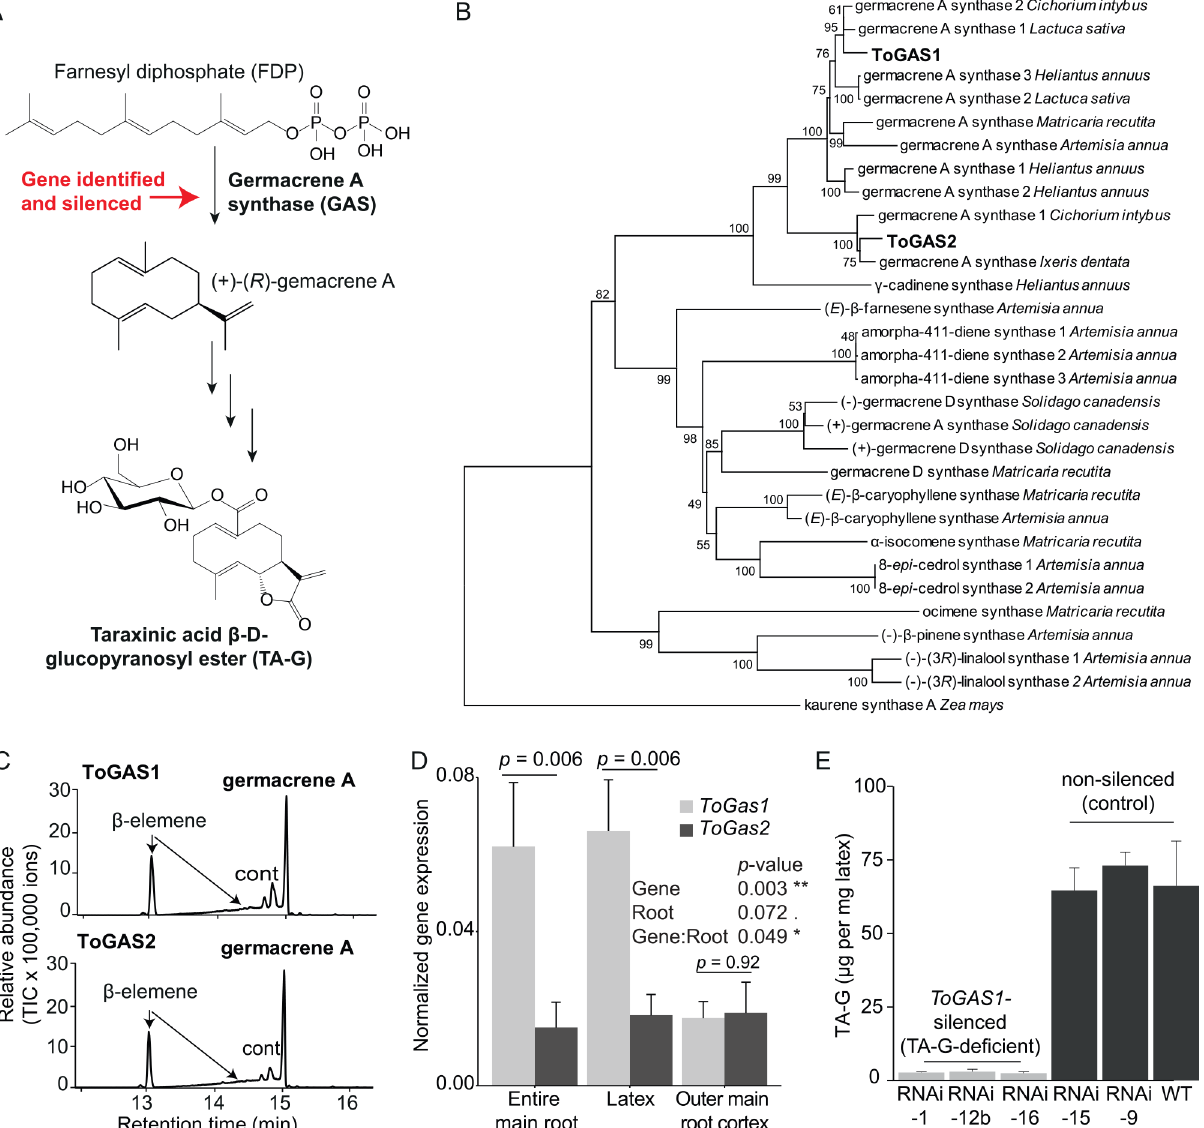
Fig 2. The germacrene A synthase ToGAS1 mediates the first committed step in latex TA-G biosynthesis. A. Partial biosynthetic pathway of TA-G. B. Phylogenetic tree of the newly identified T . officinale germacrene A synthases ToGAS1/2 and known Asteraceae terpene synthases (neighbor-joining method, n = 1,000 replicates). Bootstrap values are shown next to each node. Accession numbers can be found in S4 Table. C. GC-MS analysis of enzyme products from recombinant ToGAS1/2 expressed in Escherichia coli and incubated with the substrate FDP. Germacrene A is converted to β -elemene during hot GC injection. cont, contamination. GC-MS = gas chromatograph coupled to a mass spectrometer. D. Expression of T . officinale germacrene A synthase genes ( ToGAS1 and ToGAS2 ) in the entire main root, latex, and outer main root cortex as determined by RT-qPCR. Statistics of two-way ANOVA and pairwise comparison according to Tukey ’ s post hoc test are shown. Mean Sq = Mean of squares. n = 3. E. Silencing of ToGAS1 by RNAi generated three independently silenced lines with strongly depleted TA-G concentrations and two transformed, nonsilenced lines with similar TA-G concentrations as the parental wild type. N = 3. Underlying data can be found in S1